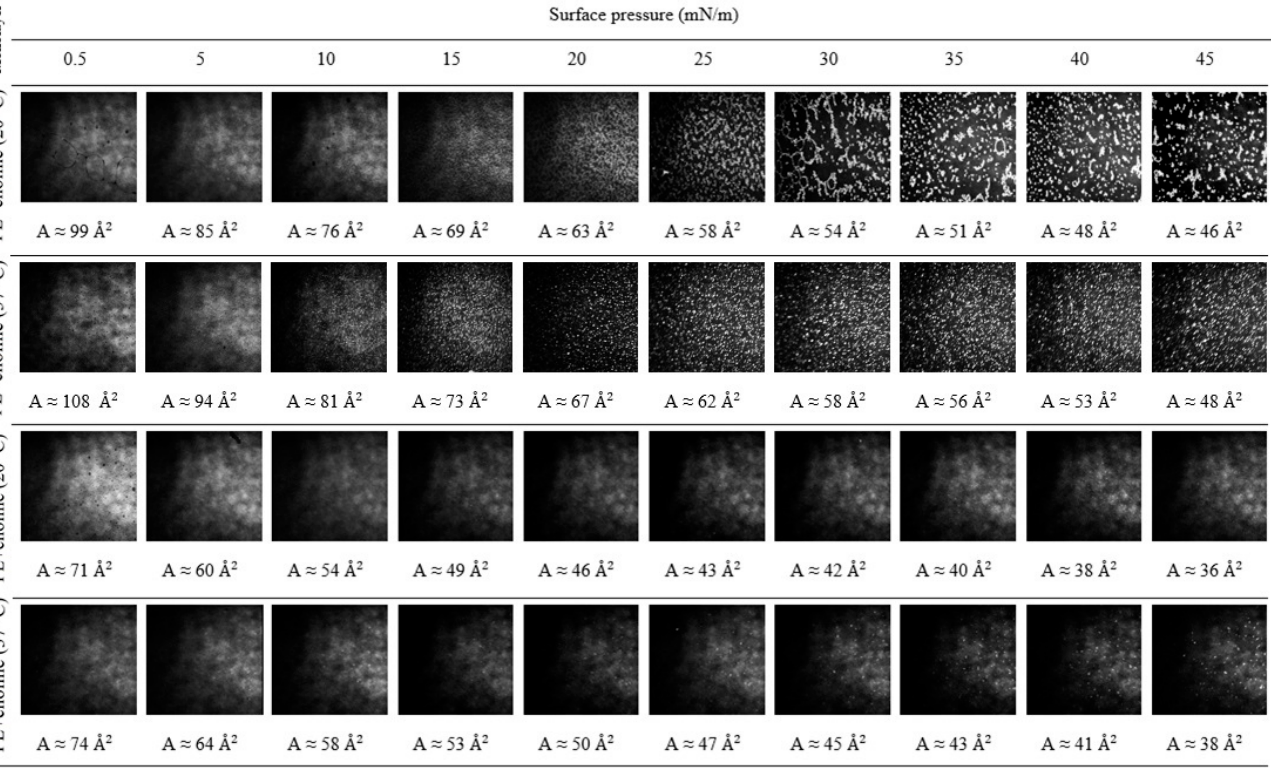
Figure 5. BAM images taken for the PL − choline and PL+choline monolayers at 20 °C and 37 °C at given values of surface pressure and mean molecular area.